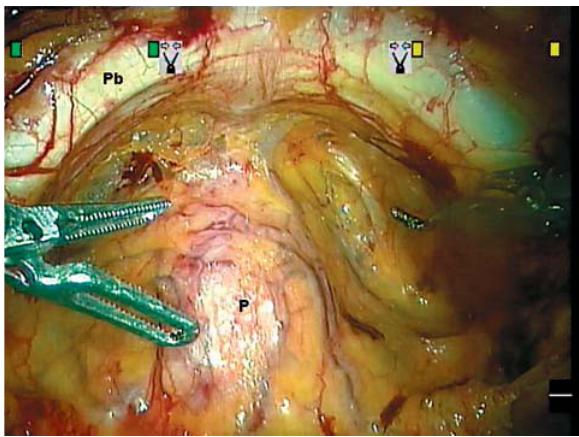
Figure 3 – Intraoperative image at the pelvis with the bladder dropped and prostate (P) and pubic bone (Pb)